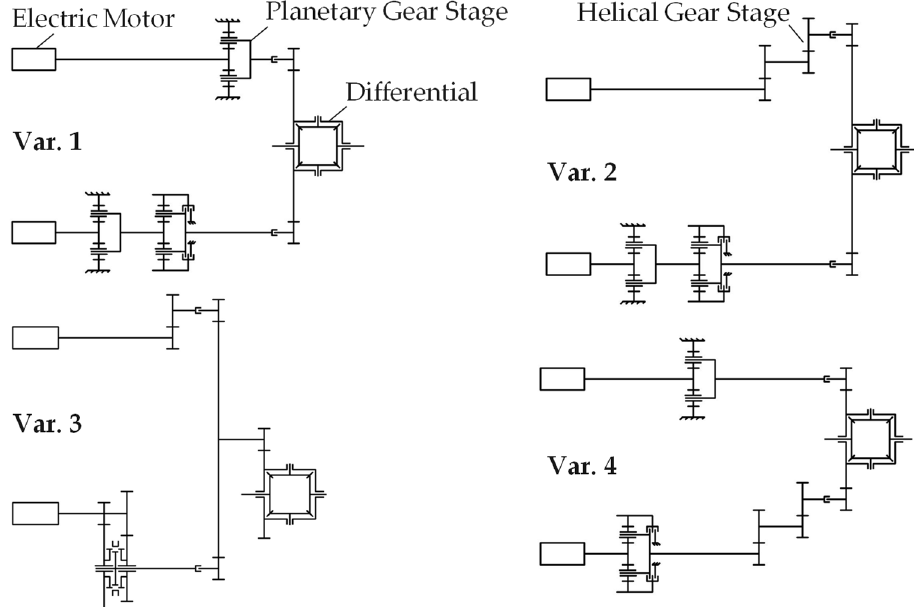
Figure 3. Exemplary selection of considered gearbox topologies according to [16,17].